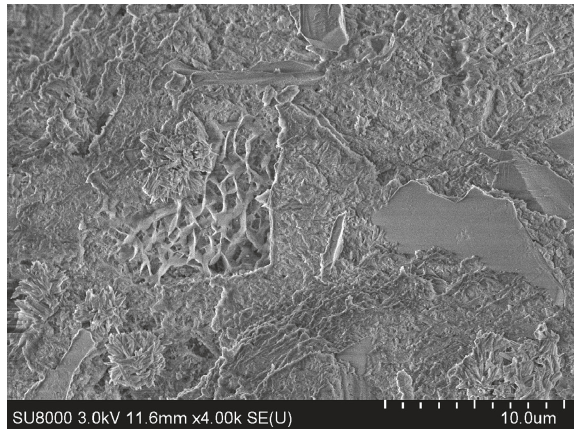
Figure 13: Micromorphology of cement stone LR2 (low